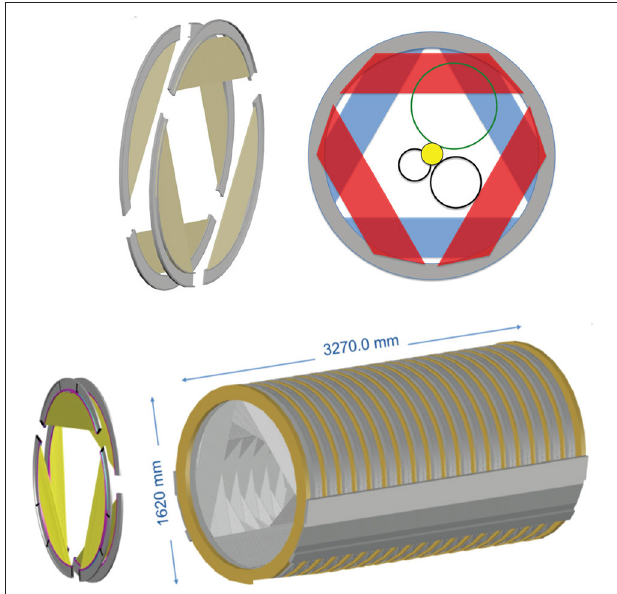
FIGURE 11 | The Mu2e tracker. The upper left picture shows panels assembled into a plane and a station. The assembled tracker is shown in the bottom figure. The upper right shows a beam’s-eye view of a station: the three circles are projections of tracks at the Michel peak (small black circle), an intermediate momentum, and the conversion energy (last in green). Figures from Miyashita [35].